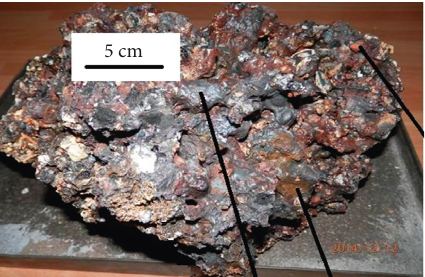
Figure 2: Incrustation from the cocombustion of brown coal and woodchips in a fluidised bed boiler. Table 1: Composition of the glass parts of the incrustation, wt. %. Sampling